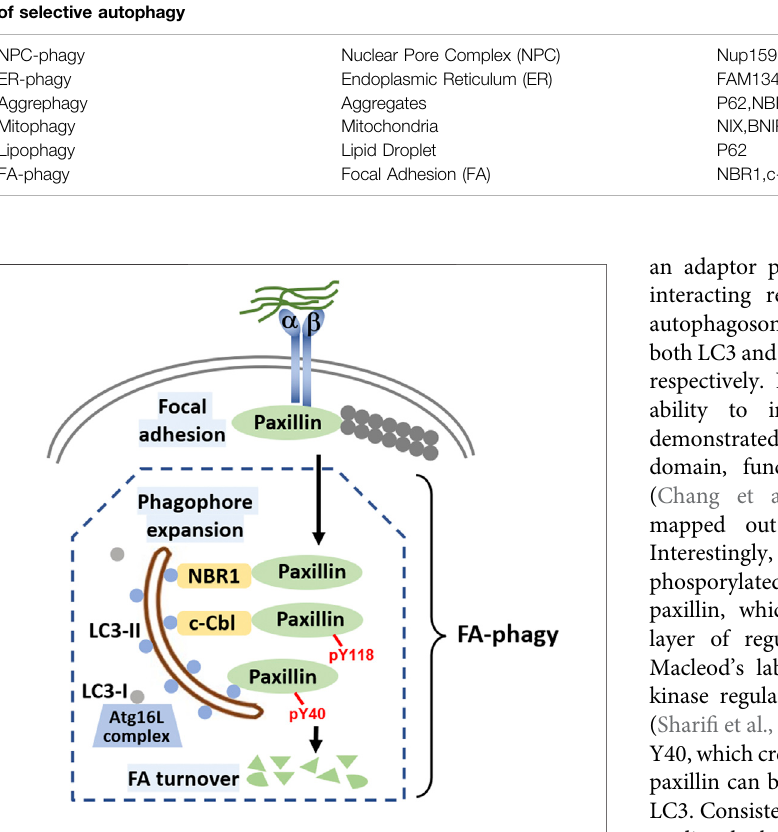
Frontiers in Cell and Developmental Biology |